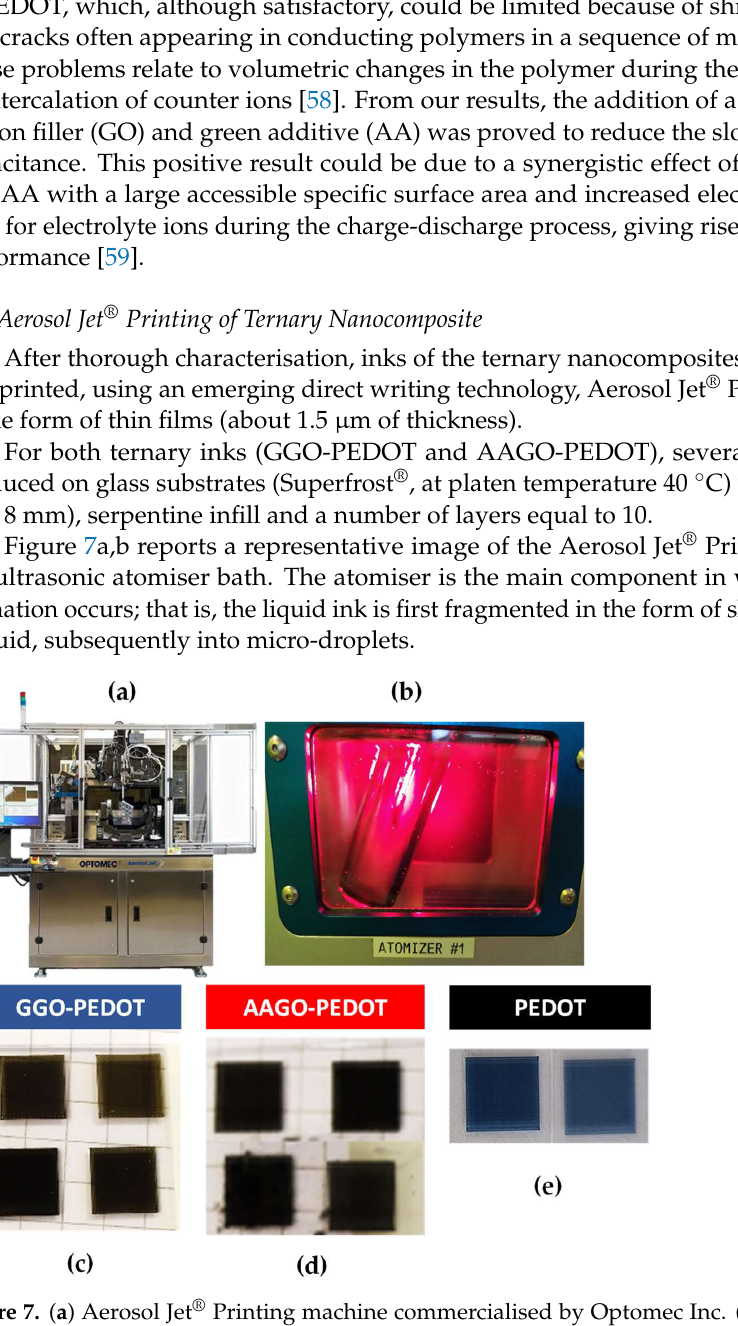
Figure 7. ( a ) Aerosol Jet ® Printing machine commercialised by Optomec Inc. (Albuquerque, NM, USA), ( b ) Atomiser in the ultrasonic configuration of Aerosol Jet ® Printing machine, ( c ) GGO- PEDOT thin films printed on a glass substrate, ( d ) AAGO-PEDOT thin films printed on a glass ( e ) PEDOT thin films printed on a glass